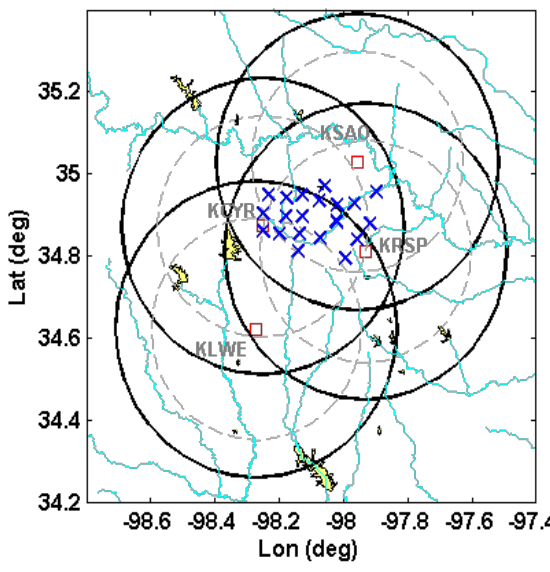
Fig. 6. Location of the USDA ground gauges in the CASA’s IP1 Fig. 6 Location of the USDA ground gauges in the CASA’s IP1 network.